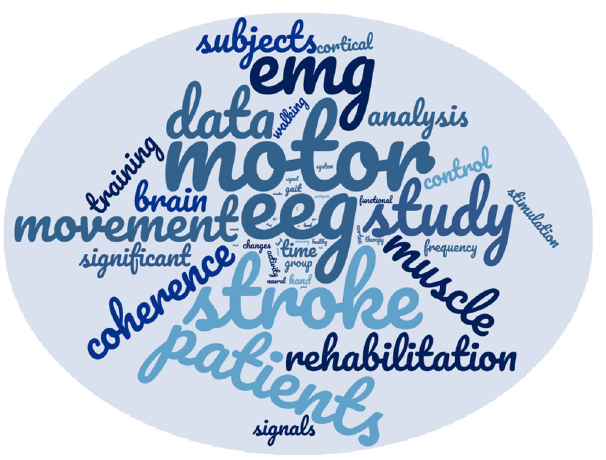
Figure 3. Word-cloud representing the 50 most cited words (excluding all the words not representing nouns and not relevant acronyms) included in the text of the papers selected in this review. The higher the size, the higher the number of citations inside the papers.